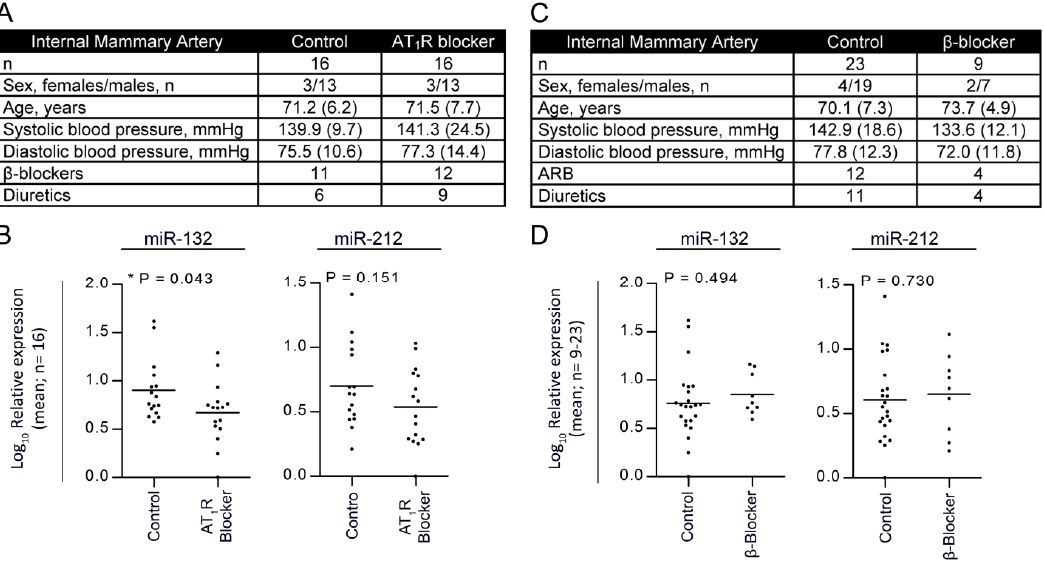
Figure 5. AngII receptor blockers and β -blockers in internal mammary artery (IMA) patients. ( A , C ) Study group information on the AngII receptor blocker (ARB) and β -blocker patient groups, respectively. None of the characteristics within the patient groups of ARBs and β -blockers were significantly different. The groups were matched for age, sex, diabetes and treatment using statins. None of the patients were simultaneously treated with angiotensin-converting enzyme (ACE)-inhibitors; ( B ) Scatter plot represents Log relative miRNA expression with mean bar, in patients treated with ARBs compared to patients treated with non-ARB ( n = 16). ( D ) Scatter plot representing Log miRNA expression with mean bar, in patients treated with β -blocker ( n = 9) compared to patients treated with non- β -blockers ( n = 23). Expression is normalized to two stably expressed reference genes. Reference genes used for normalization: miR-103 and miR-191 (M: 0.804, CV: